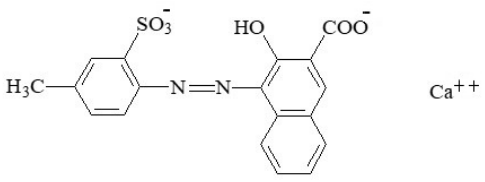
Figure 28. Structural formula of litholrubine BK (E180). Figure 29. Structural formula of litholrubine BK